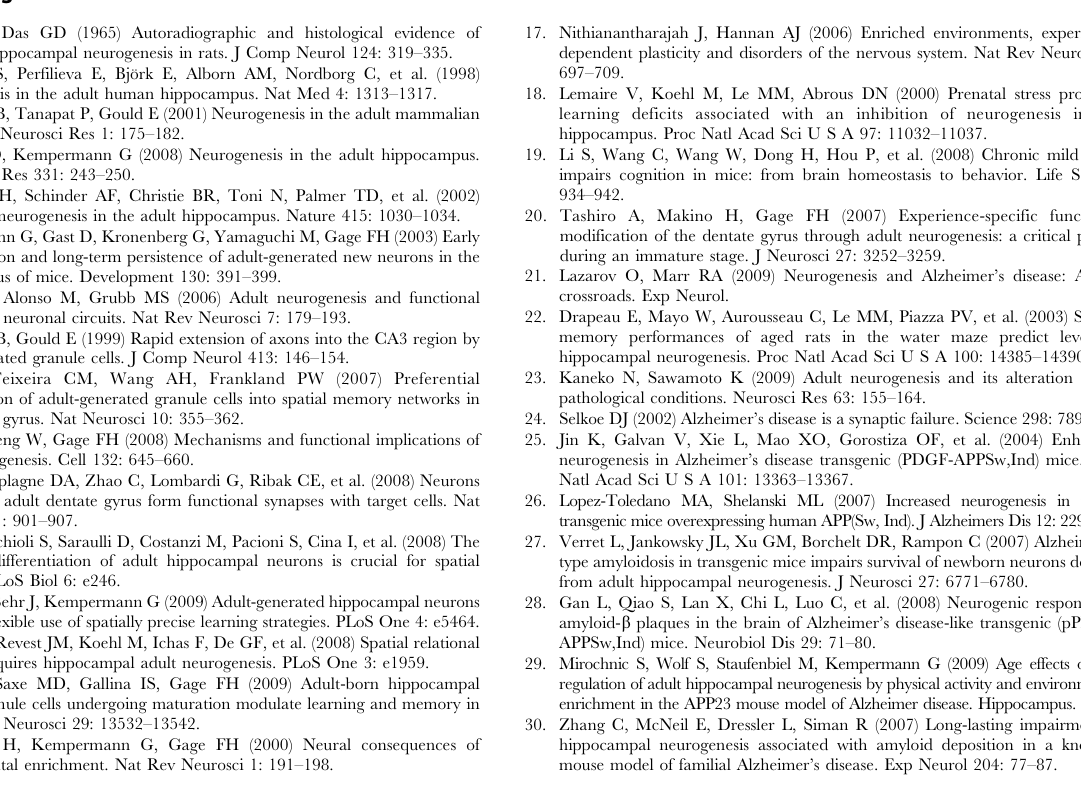
Figure S1 Animal housing conditions. Picture showing the environmental enriched (left) or standard (right) housing cages. Numbers above the picture indicate the floor area of each cage. (TIF) Figure S2 Correlation of adult neurogenesis and mem- ory in APP mice. Correlation plot analysis of memory index taken as percentage of time in the target quadrant during the probe trial in the MWM vs. number of BrdU/NeuN cells in WT and APP Sw,Ind mice. Memory index correlated with the number of new generated neurons in APP Sw,Ind mice (r 2 = 0.3067; p = 0.0085) but not in WT mice (r 2 = 0.05728; p = 0.2895).